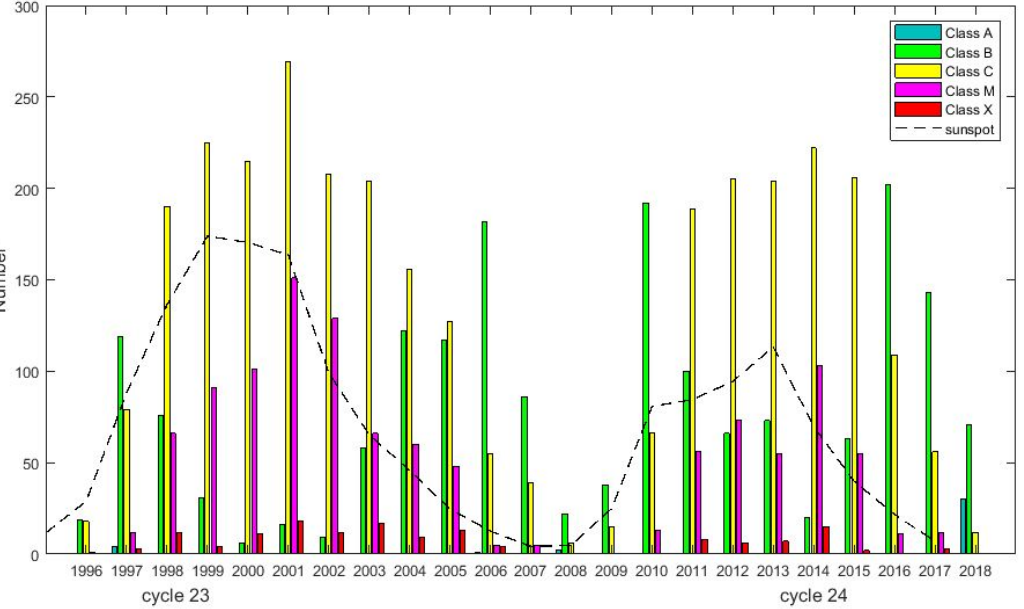
Figure 2. Variation of solar flare occurrence during solar cycles 23 and 24. A-class (blue), B-class (Green), C-class (yellow), M-class (Violet) and X-class (Red). The dotted line represents the sunspots number observed on the sun’s surface from 1996 to 2018.